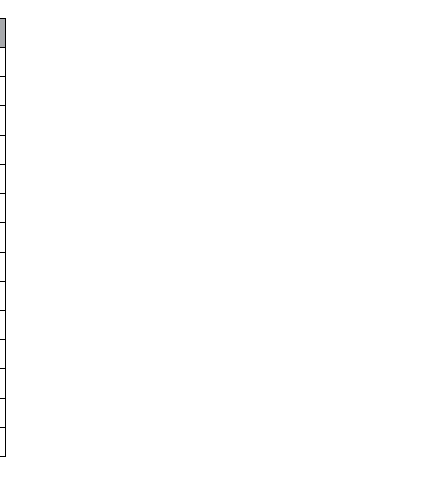
Table 4. Adverse events and surgical